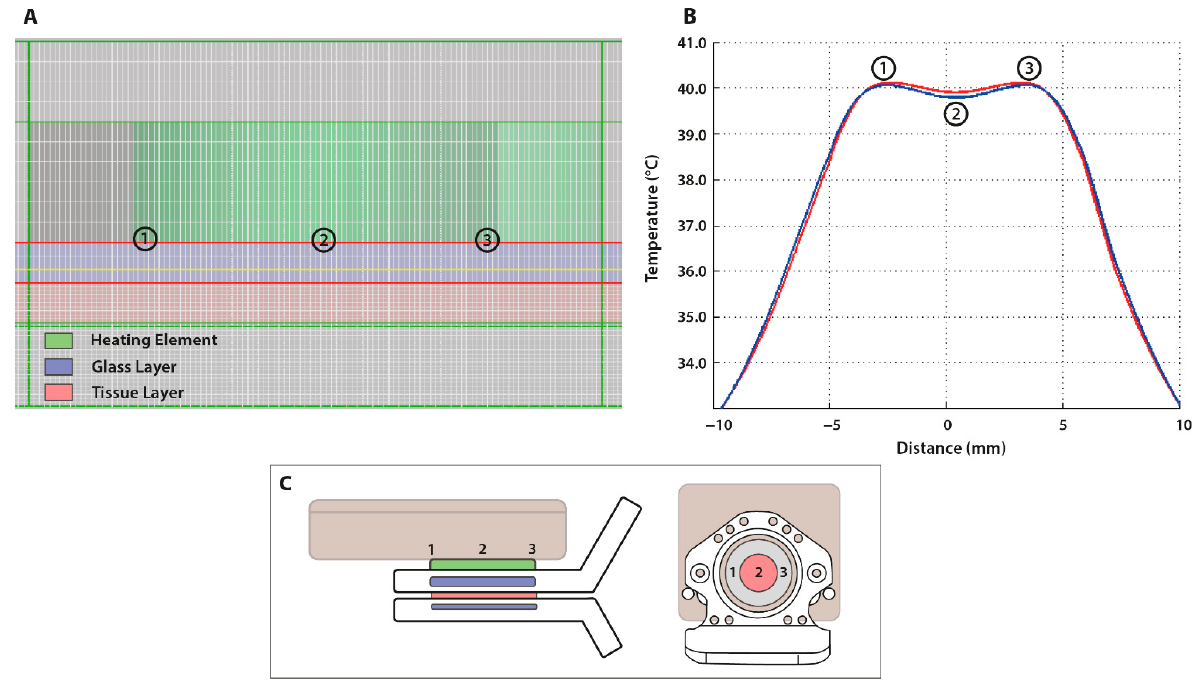
Figure 5. SEMCAD X simulations of the temperature distribution within the DSC heating element. ( A ) Image from the SEMCAD X software showing the simulated DSC model, which consisted of a heating element (green) and the skinfold chamber window being a combination of tissue (red) sandwiched between two glass plates (blue); ( B ) the temperature profile simulated at the border between the heating element (green) and the lower glass plate (blue); ( C ) illustrations of the dorsal skinfold chamber model in relation to the SEMCAD X simulations. The edges of the heating element (point 1 and 3) are shown to have been indirect contact with the glass layer, while the hollow bore allowed for transillumination (point